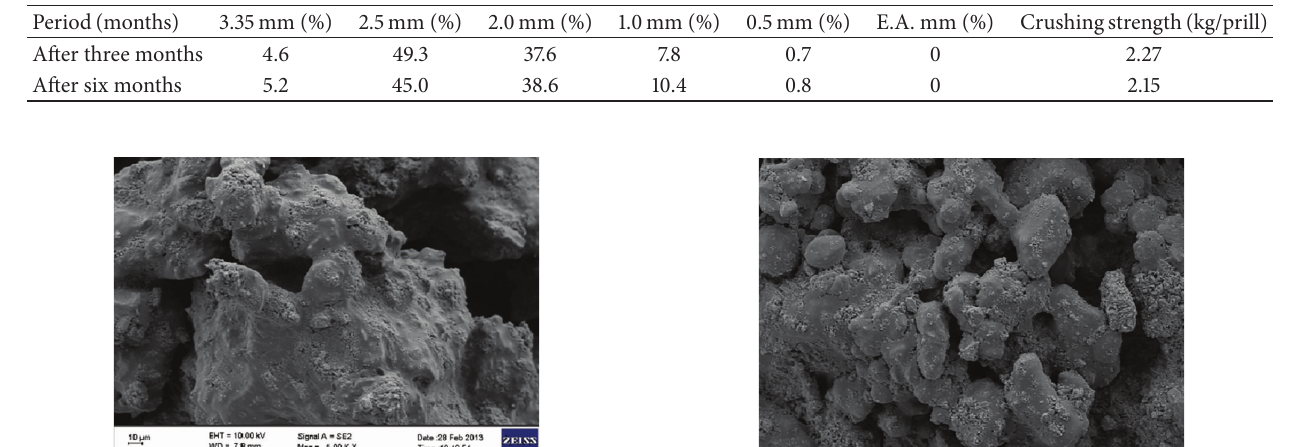
Table 1: Screening analysis after three months and six months.